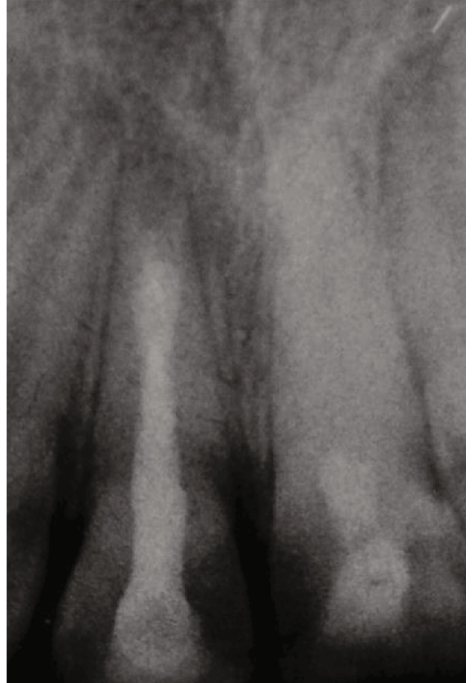
Figure 8: Root canal plugging of 11: MTA+gutta. Complete root canal obliteration of